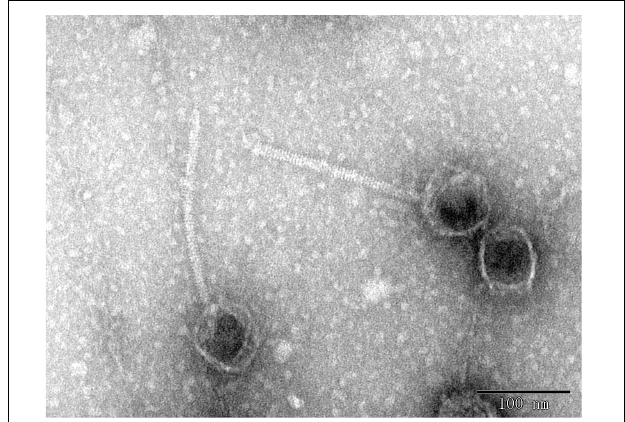
FIGURE 1 | Phage morphology observed using